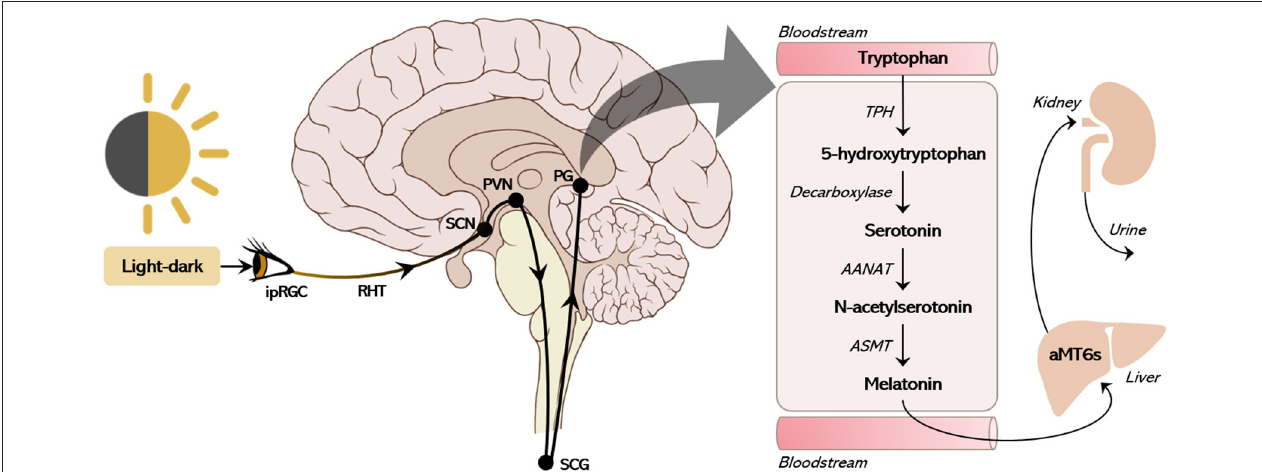
FIGURE 2 | The canonical pathway of pineal melatonin production. The suprachiasmatic nucleus (SCN) receives environmental photic information collected by intrinsically photosensitive ganglion cells (ipRGC) in the retina. The ipRGCs express the photopigment melanopsin, which transduces light wavelengths into neural input through the retinohypothalamic tract (RHT) to the SCN. The SCN constitutively inhibits the hypothalamic paraventricular nucleus (PVN) via GABAergic projection. In the absence of light, the PVN activates the ganglion cervical nuclei (SCG, via the intermediolateral column of the medulla) triggering noradrenergic fibers that innervate the pineal gland (PG), ultimately releasing the co-transmitters noradrenaline and ATP. This sympathetic stimulus triggers the action of arylalkylamine N-acetyltransferase (AANAT) converting serotonin (5TH) into N-acetylserotonin (NAS) within the pinealocyte. With the constitutive action of N-acetylserotonin O-methyltransferase (ASMT), NAS is then converted to melatonin and immediately released into the cerebrospinal fluid and bloodstream. Through first-pass metabolism in the liver, melatonin is converted to 6-sulfatoxymelatonin (aMT6s), which is then excreted in the